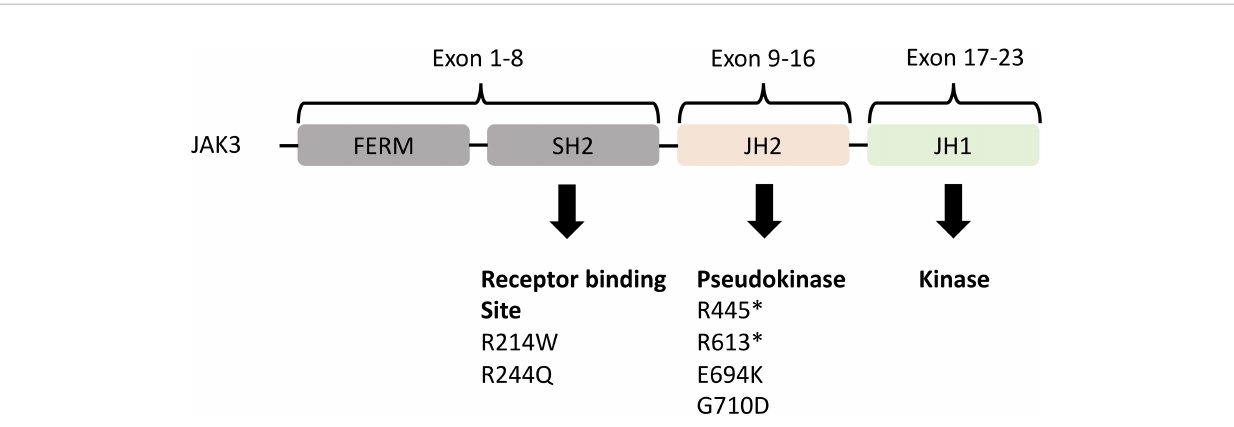
FIGURE 2 | Representation of the JAK3 domains and their encoding exons (24, 25) with JH2 (pseudokinase domain) and JH1 (kinase domain) being the most important. Below the domains are the somatic mutations identi fi ed in both M-PTLD, P-PTLD, CHL-PTLD and FFH-PTLD patients. *nonsense mutation.